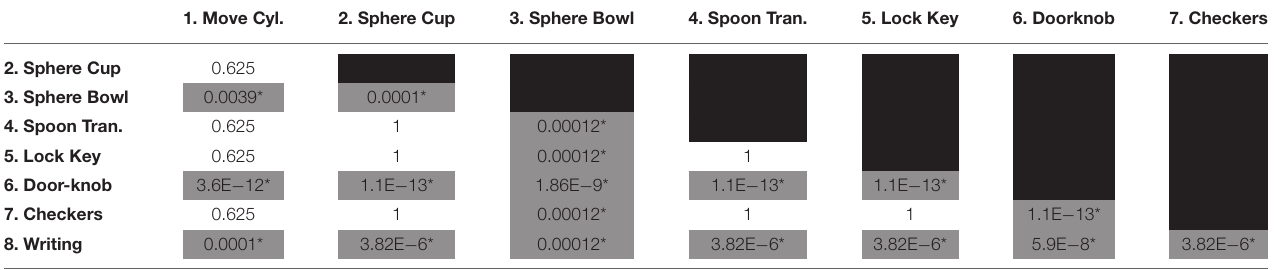
TABLE 3 | Statistical comparison of task completion rate in VR for all tasks.